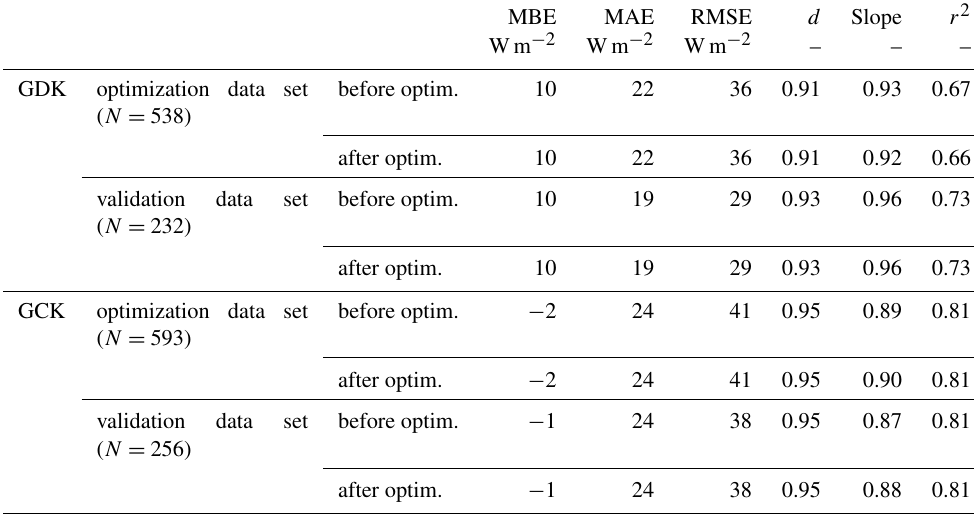
Table B1. Statistical parameters before and after the parameter optimization for the error assessment at the study sites. MBE, MAE, RMSE, and d indicate mean bias error, mean absolute error, root mean square error, and index of agreement, respectively. Slope and r 2 are from the linear regression analysis. The default values of K L , n , and r 0 were 0.2 (0.2), 2 / 3 (2 / 3), and 2 (2) for the GDK (GCK), respectively. After the optimization, those values changed to 0.1966 (0.2314), 0.7279 (0.6930), and 2 (2) for the GDK (GCK),